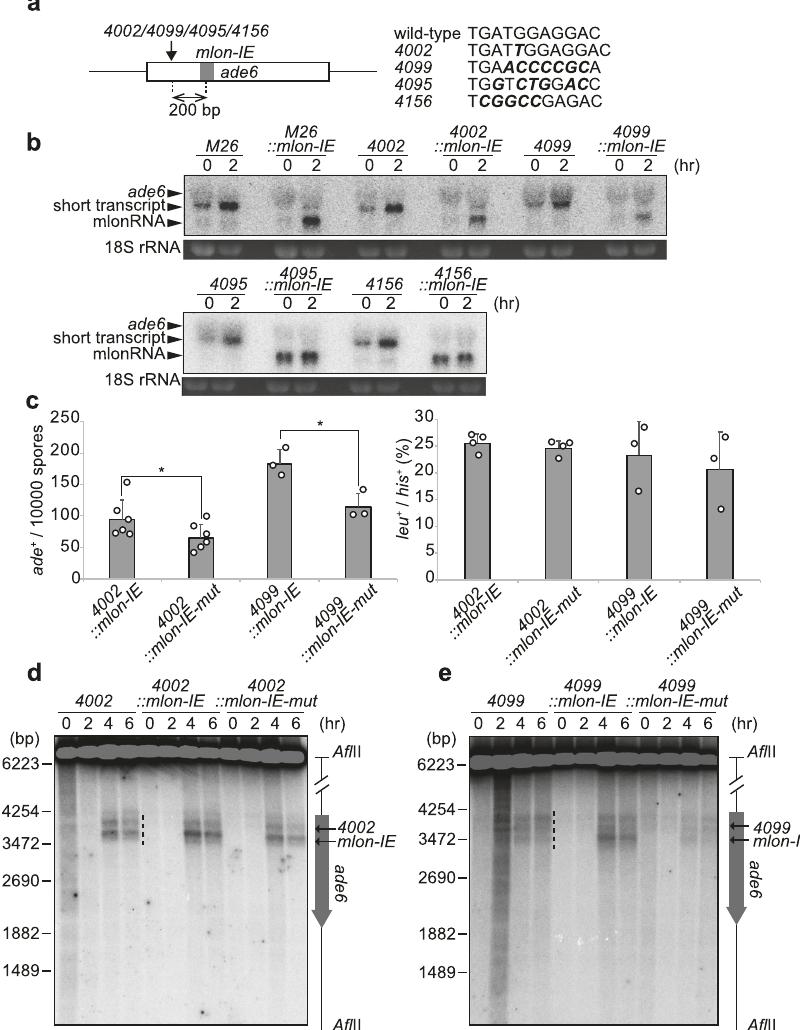
Fig. 3 mlon-IE works downstream of binding sequences for transcription factors, CCAAT-binding factor and Rst2. a Schematic representation of ade6- 4002 , ade6-4099 , ade6-4095 and ade6-4156 . 4002 insertion, 4099 mutation, 4095 mutation and 4156 mutation are shown (bold italic). mlon-IE was translocated 200 bp downstream from the 4002 / 4099 /4095/4156 mutation. b ade6 transcripts of indicated cells in meiosis. Cells were cultured, as described in Fig. 1c. c Recombination rates of indicated cells were assessed, as described in Fig. 2a. Error bars represent standard deviations. n = 3 or 6 biologically independent experiments. P values were calculated using the unpaired one-sided Student ’ s t -test: * P < 0.05. d , e Meiotic DSBs of indicated cells were detected by Southern blotting, as described in